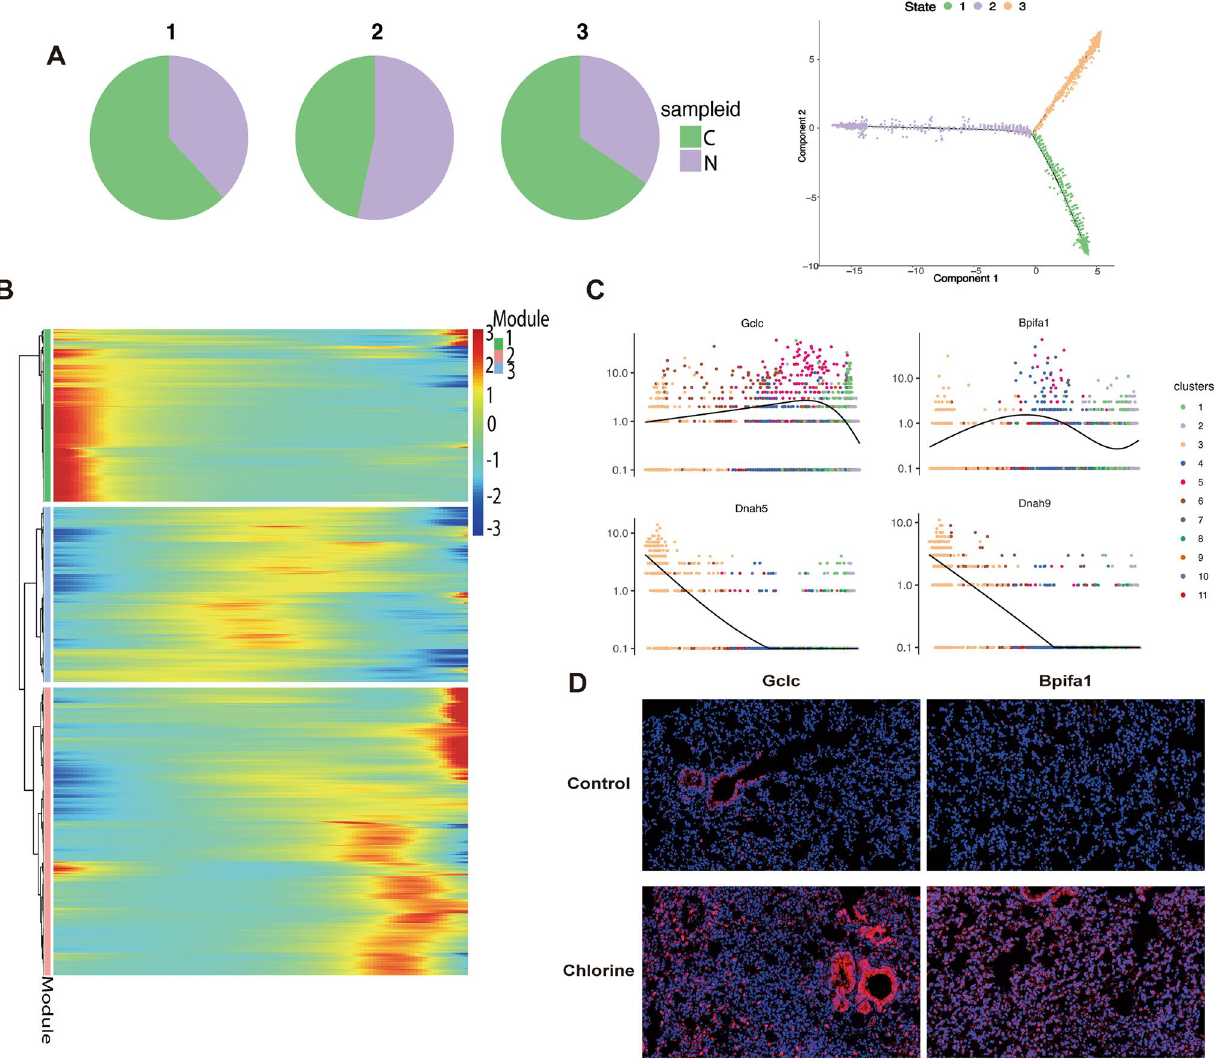
Figure 3. Pseudo-time analysis of epithelial cells. ( A ) Cell trajectories on pseudotime of lung epithelial cells. ( B ) Pseudotemporal dynamics of pseudotime-dependent genes in lung epithelial cells. Each row is normalized to its peak value along the pseudotime. ( C ) Pseudotime ordered single-cell expression trajectories for Gclc, Bpifa1, Dnah5 and Dnah9. ( D ) Immunofluorescence analysis of Gclc and Bpifa1. Scale bars 50 μm, n = 6, Gclc and Bpifa1(red), cell nuclear (blue), N control group, C Cl 2